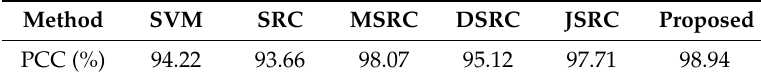
Table 4. Comparison with reference methods.